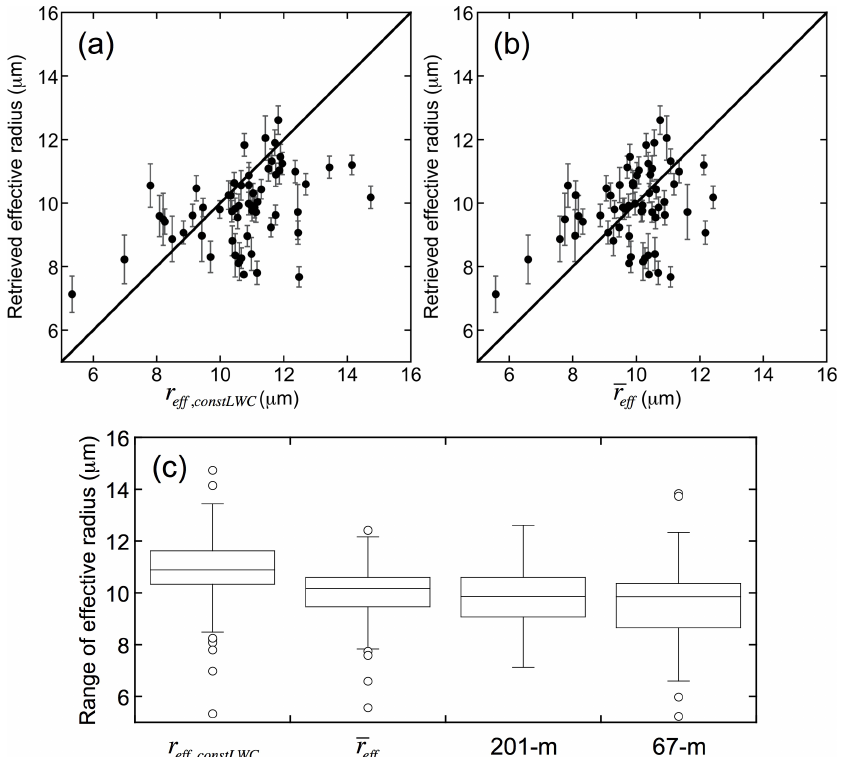
Fig. 6. Scatter plots of retrieved versus true effective radius from simulations. Two “true” effective radii are calculated: r eff , constLWC from the assumption of constant liquid water content in the vertical; ¯ r eff from averaging droplet radii over all levels in the cloud layer. In addition, two sets of retrieved effective radii are used: one is based on simulation at 201 m resolution, the other is at 67m resolution. (a) and (b) are retrievals at 201 m resolution plotted against r eff , constLWC and ¯ r eff . The error bars represent the standard errors (discussed in Sect. 2). (c) Box plots for the two types of the true effective radii, and the two sets of retrievals.